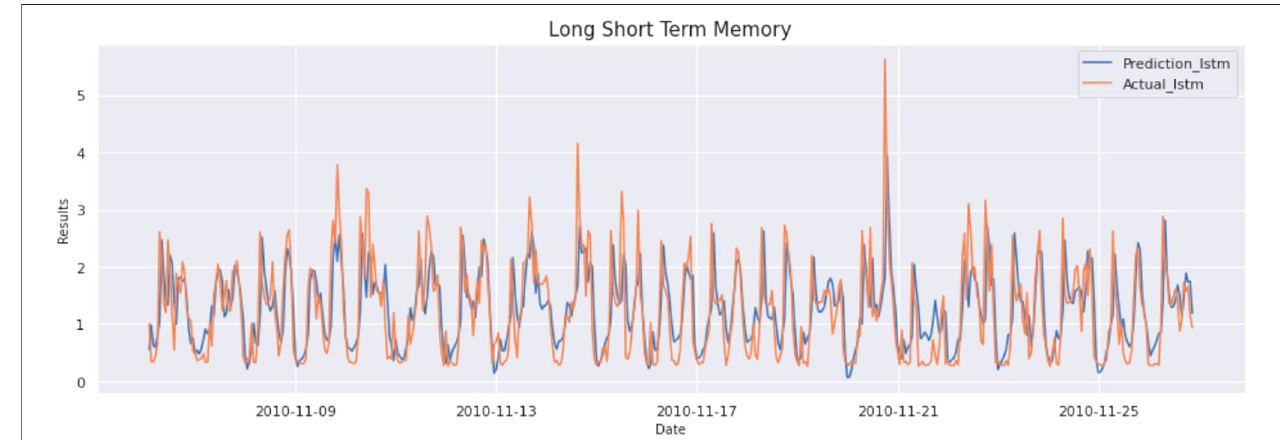
FIGURE 2 | Prediction vs Actual result of LSTM model (Household Electricity Data).